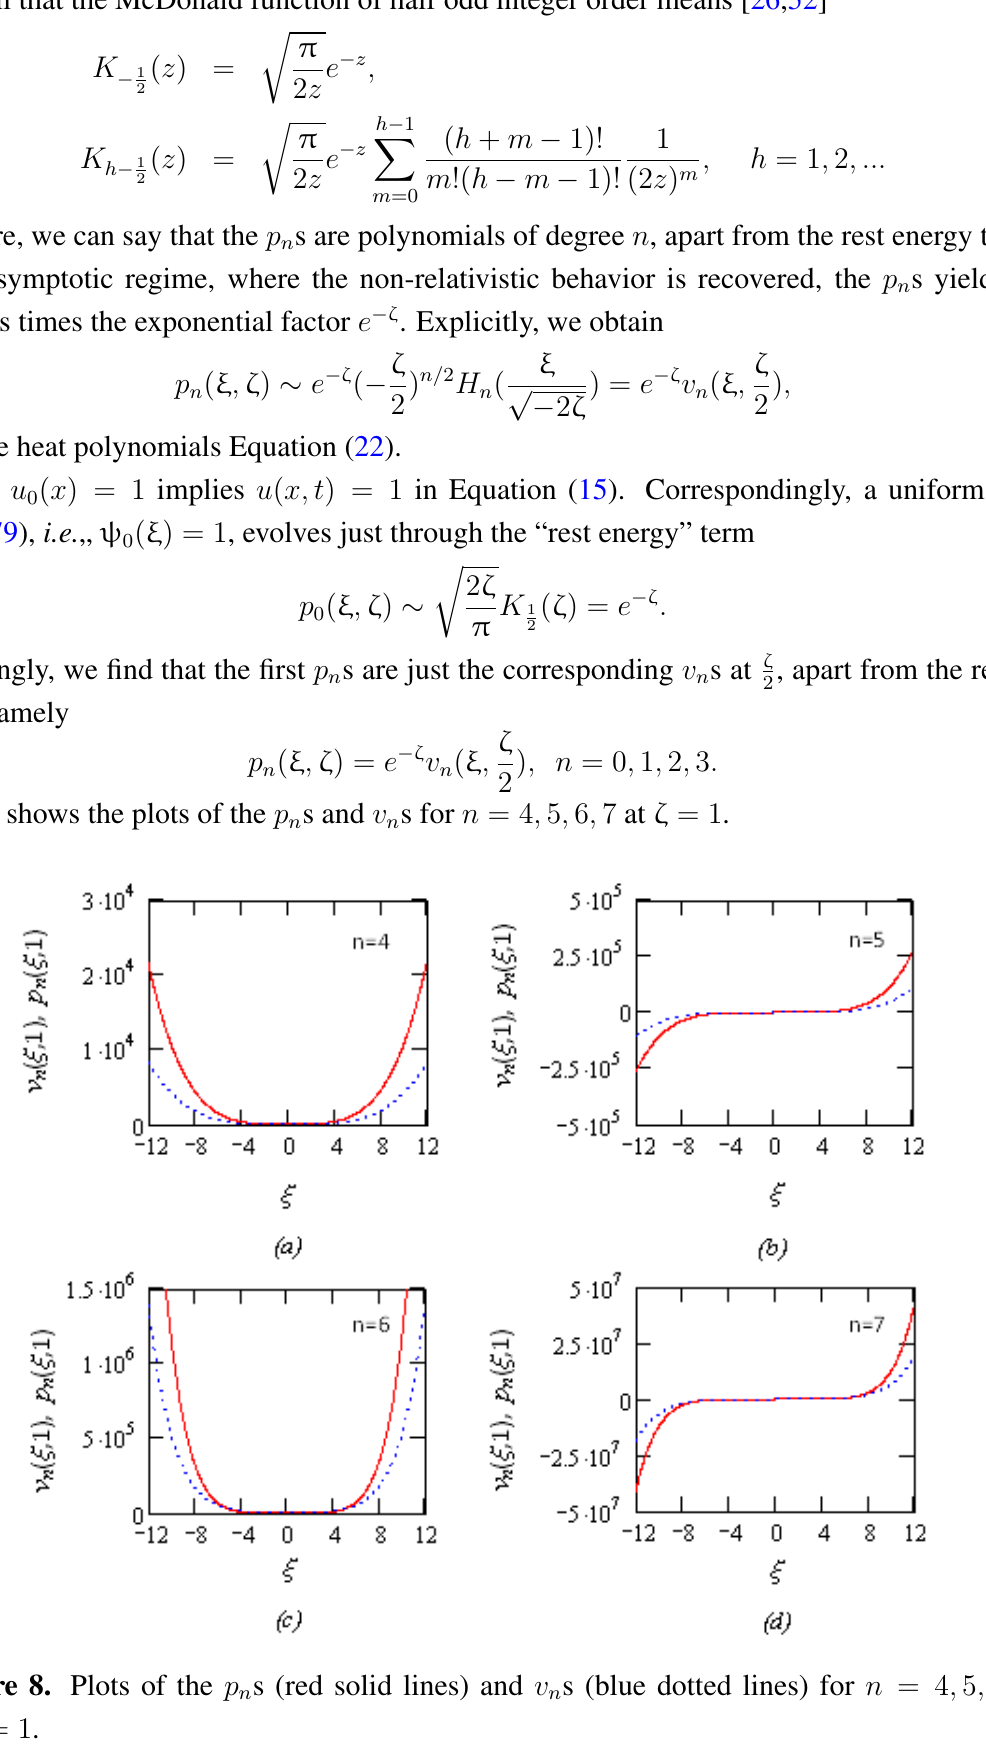
s (blue dotted lines) for n = 4 , 5 , 6 , 7 n